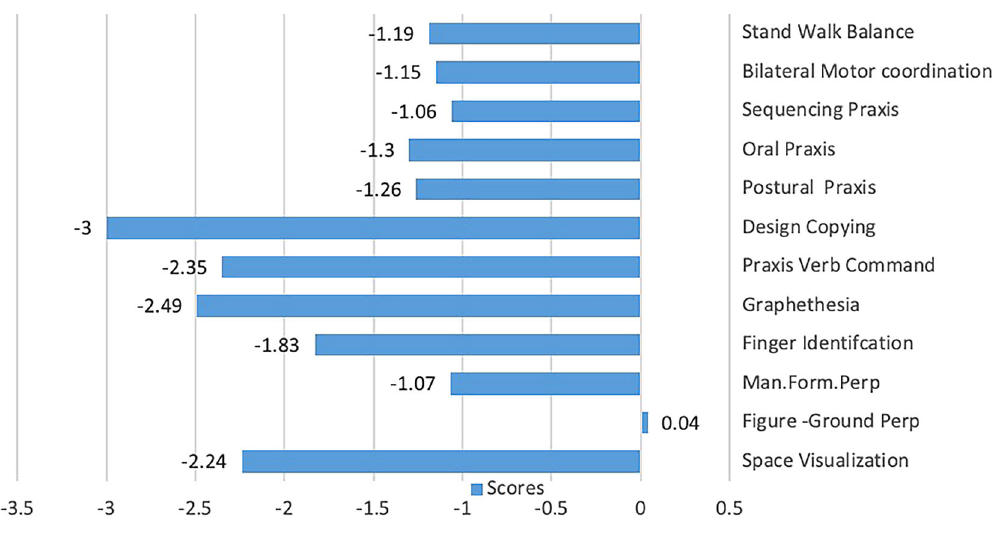
Figure 1. L ’ s Sensory Integration and Praxis Tests scores.